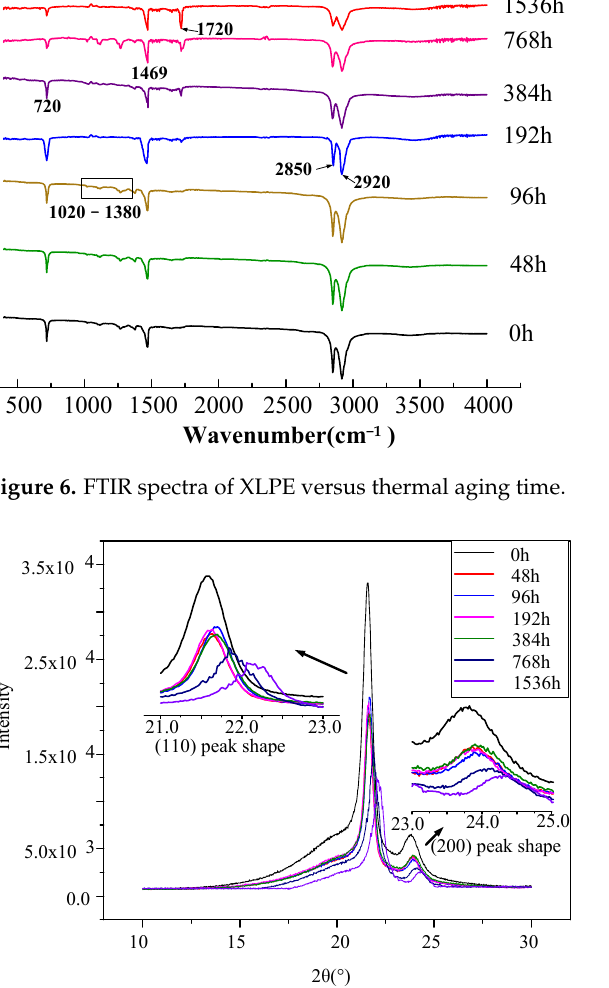
Figure 7. XRD curves versus aging time. According to the specific changes in crystal diffraction peaks, there is no obvious change in the position of the diffraction peaks during the whole aging period, indicating that the basic crystal form of each aging stage is the same. The diffraction intensities of the (110) and (200) peaks decrease with aging time after 384 h. In addition, at the end of the middle stage of thermal aging (after 384 h), serrated protrusions appeared in the XRD spectrum; that is, the diffraction intensity increased or decreased near the diffraction peak. With aging time increasing, the number of zigzag distortion protrusions increases and the peak distortion becomes